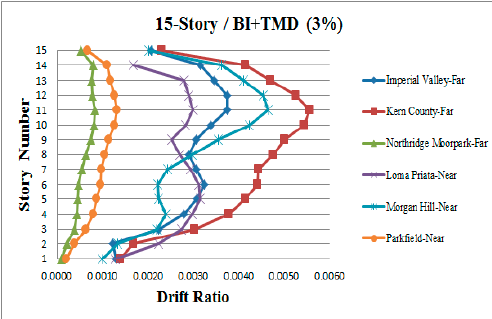
Figure A32. Drift ratios for 15-story base-isolated building with 1 TMD.